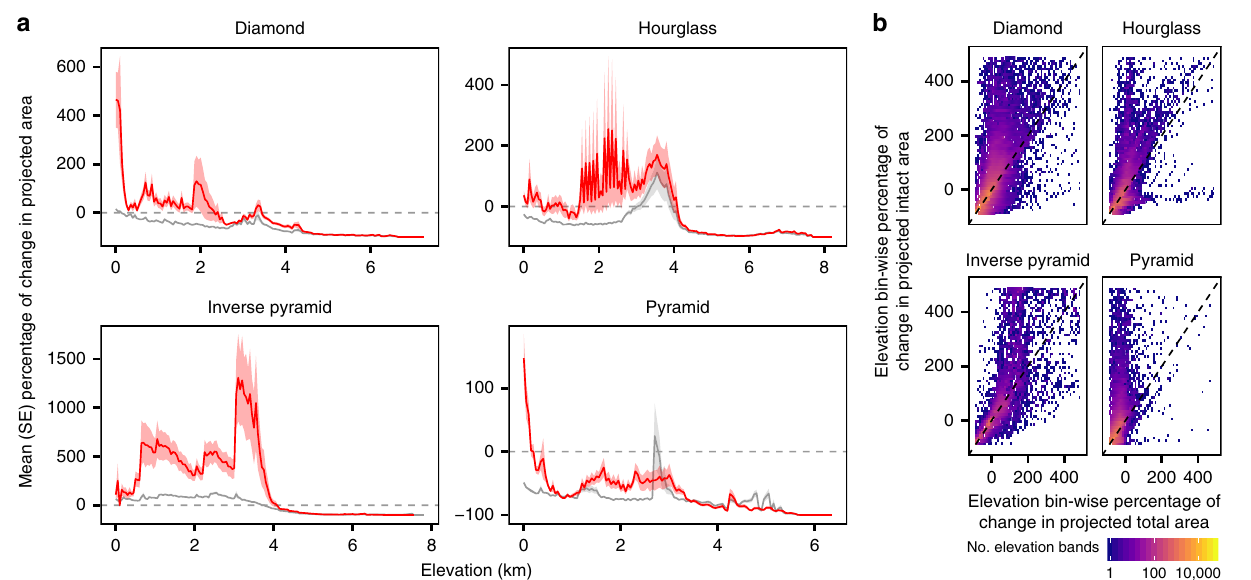
Fig. 3 Average projected area changes for species undergoing elevational range shifts. a Mean (lines) and standard error (shaded regions) percentage of change in projected total (gray lines) and intact (red lines) land area across all modeled species and all mountain ranges by mountain classi fi cation. b Elevation bin-wise comparison of percentage of change in projected total and intact area. Dashed line is 1:1 line. Cells are colored by the total number of elevation bands (50 m) across modeled species and all mountain ranges, with panels arranged by mountain classi fi cation based on total area availability. See text and “ Methods ” section for details of modeled range shifts and Supplementary Fig. 6 for analogous results using RCP 8.5 for panel a